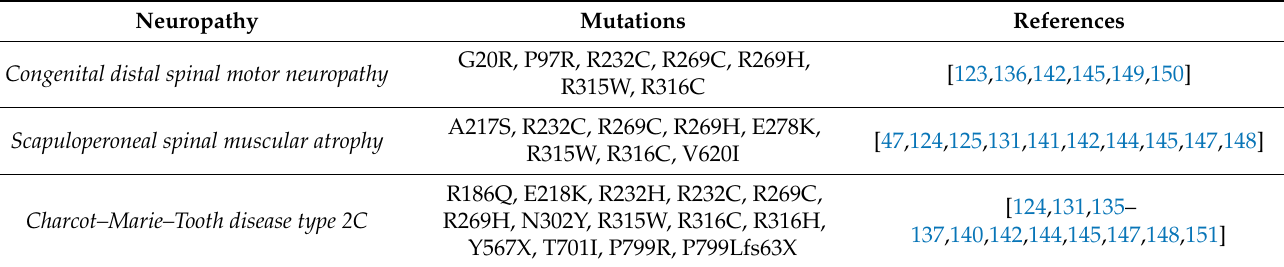
Table 2. Mutations causing different types of